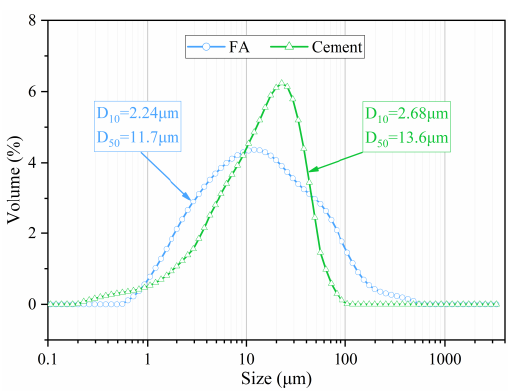
Figure 3. Particle size distributions of OPC and FA.